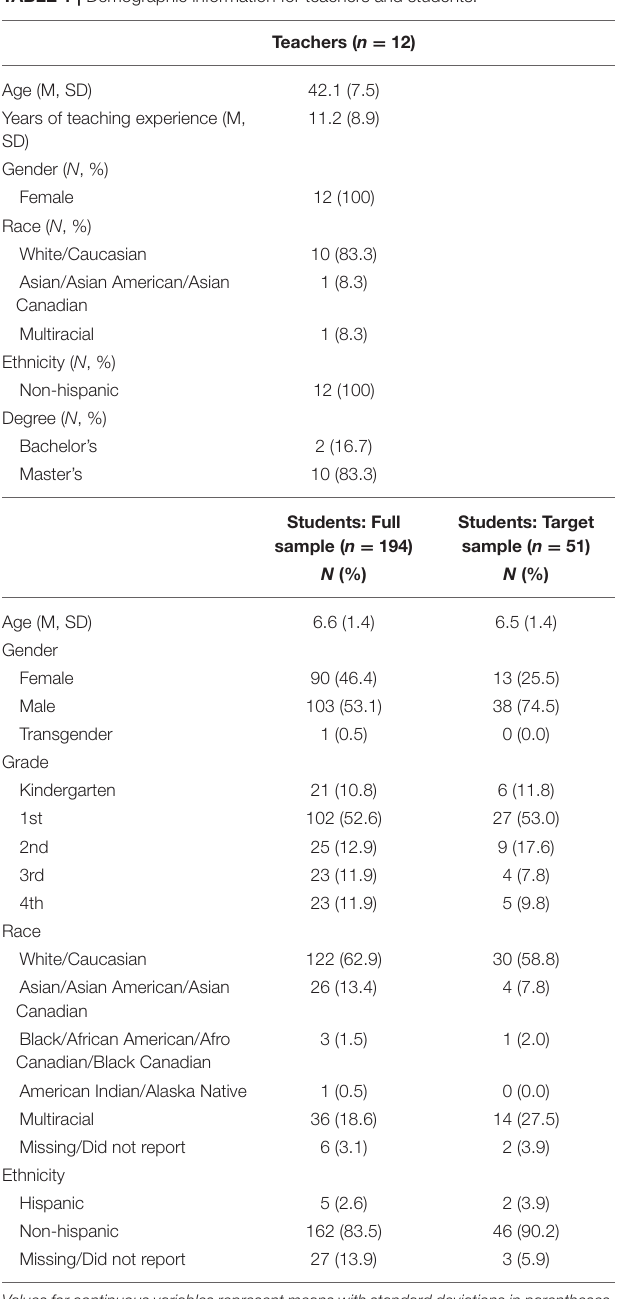
TABLE 1 | Demographic information for teachers and